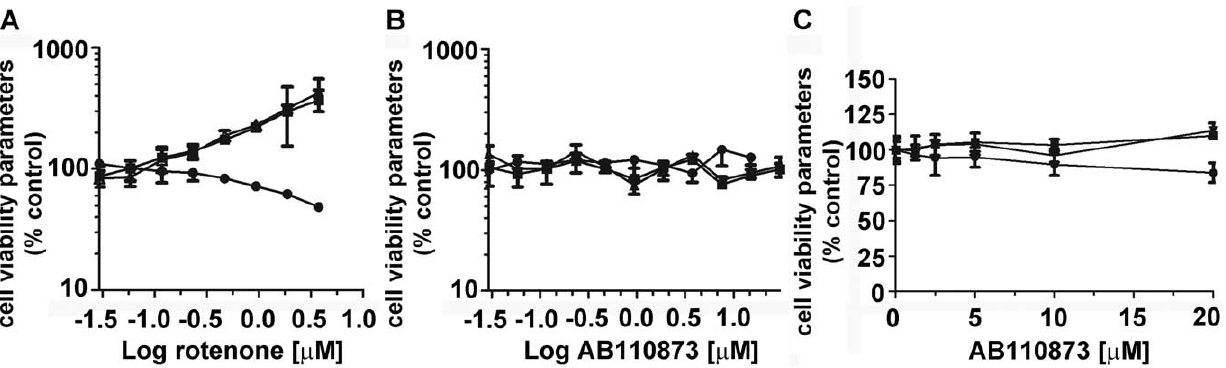
Figure 4. Assessment of the cytotoxic potential of the silane AB110873 and of rotenone. HEK-293 cells or BV2 cells were incubated with rotenone or AB110873 for 24 h, followed by incubation for 30 min with staining solution containing Hoechst 33342, SYTOX Green and dihydroethidium. After fixation and washing, fluorescence was analyzed using Cellomics ArrayScan high-content screening system as described in the Methods section. A , Effect of rotenone on cytotoxicity parameters measured in HEK-293 cells. Filled circles , average cell number per field; filled squares , cytoplasmic ROS production assessed by staining with dihydroethidium; filled triangles , membrane permeability assessed by SYTOX Green staining. Effect of the silane AB110873 on cytotoxicity parameters measured in HEK-293 cells ( B ) and in BV2 cells ( C ). Data show one of three independent experiments performed in eight replicates (mean 6 SD, n=8).